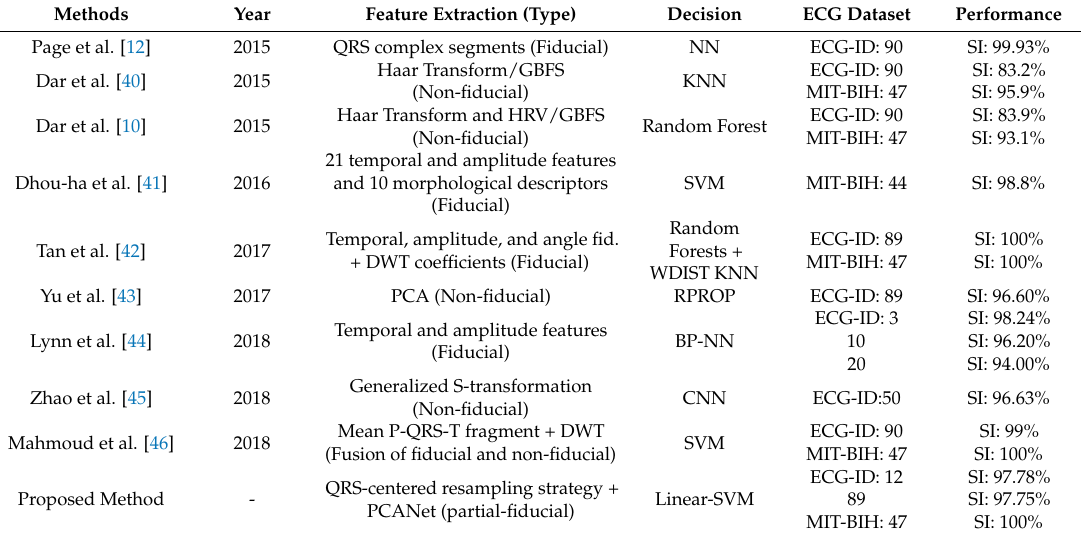
Table 10. Performance comparison with state-of-the-art works (SI-Subject